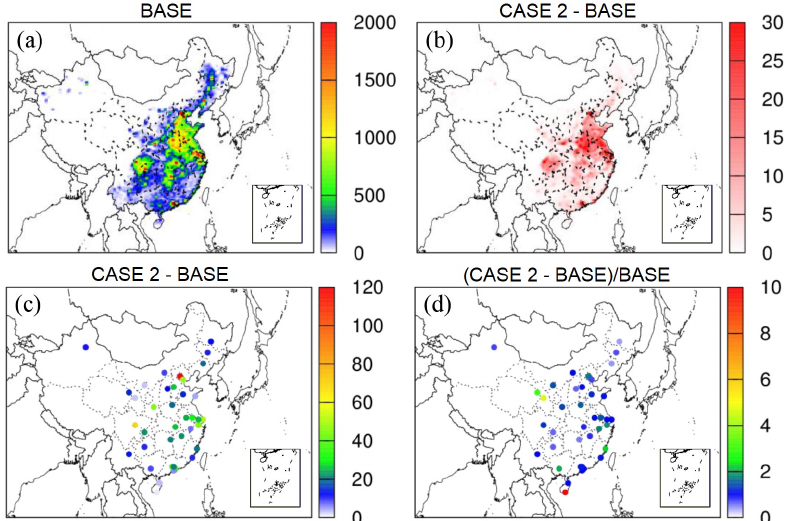
Figure 4. The total PM 2 . 5 -related premature mortality rate of (a) BASE case and its difference from CASE 2 across China (b) and in major cities (c, d) .